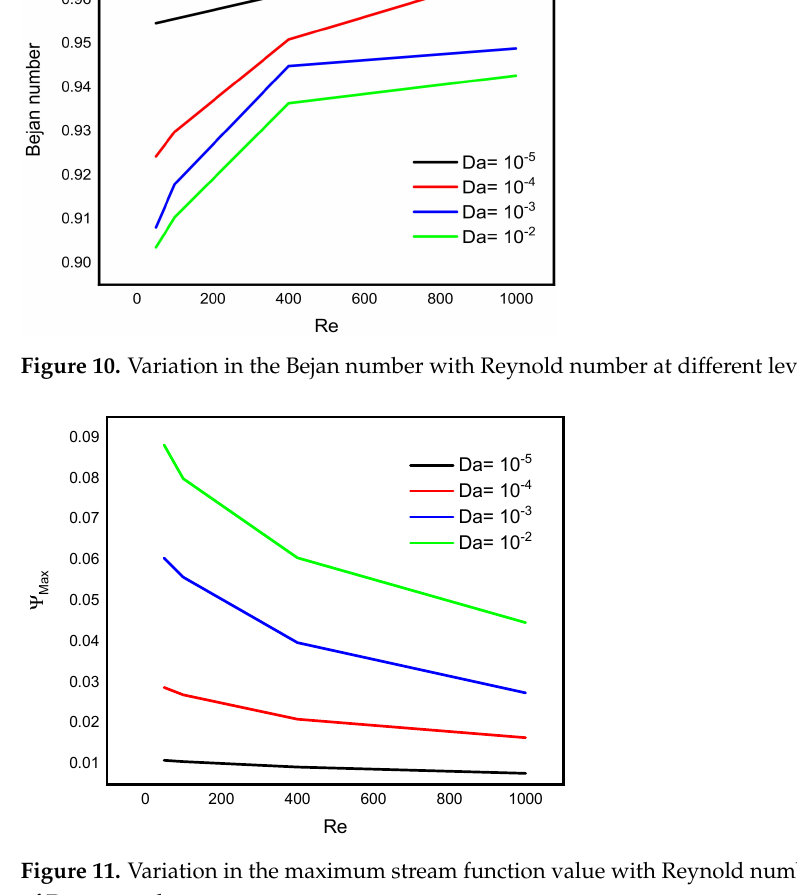
Figure 11. Variation in the maximum stream function value with Reynold number at different levels of Darcy number.